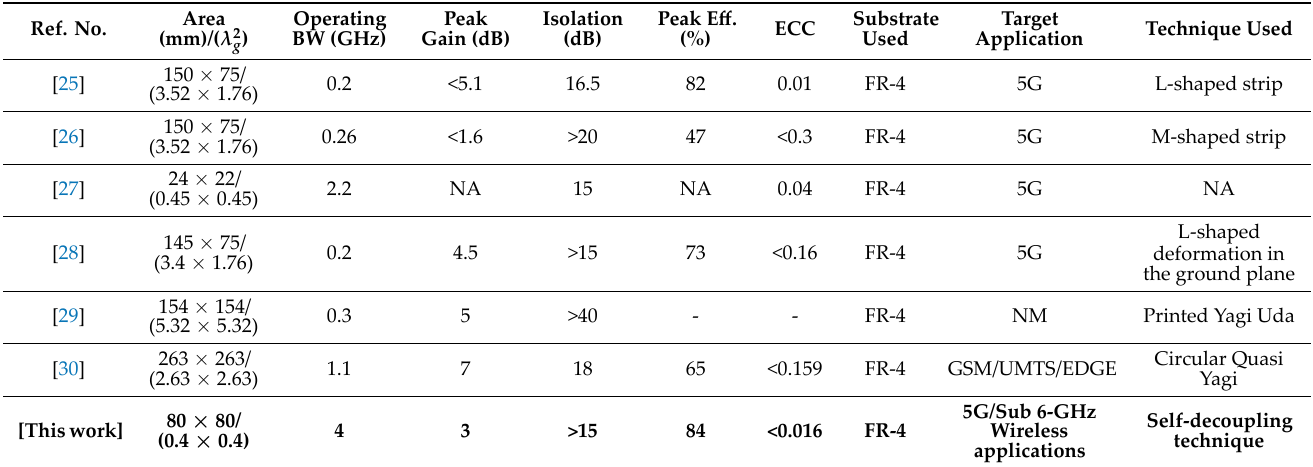
Table 2. Comparison of proposed antenna array with previous